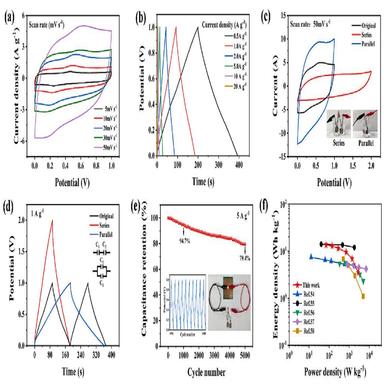
Electrochemical performance of symmetric SAC-MnO//SAC-MnO supercapacitors. (a) CV curves of SAC-MnO//SAC-MnO at different scan rates; (b) GCD curves of SAC-MnO//SAC-MnO at different current densities; (c) CV curves of SAC-MnO//SAC-MnO in series and parallel connection at a scan rate of 50 mV s − 1 ; (d) GCD curves of SAC-MnO//SAC-MnO in series and parallel connection at 1 A g− 1 ; (e) Cycling performance of SAC-MnO//SAC-MnO device at 5 A g− 1 ; (f) Ragone plots of SAC-MnO//SAC-MnO versus other published sup